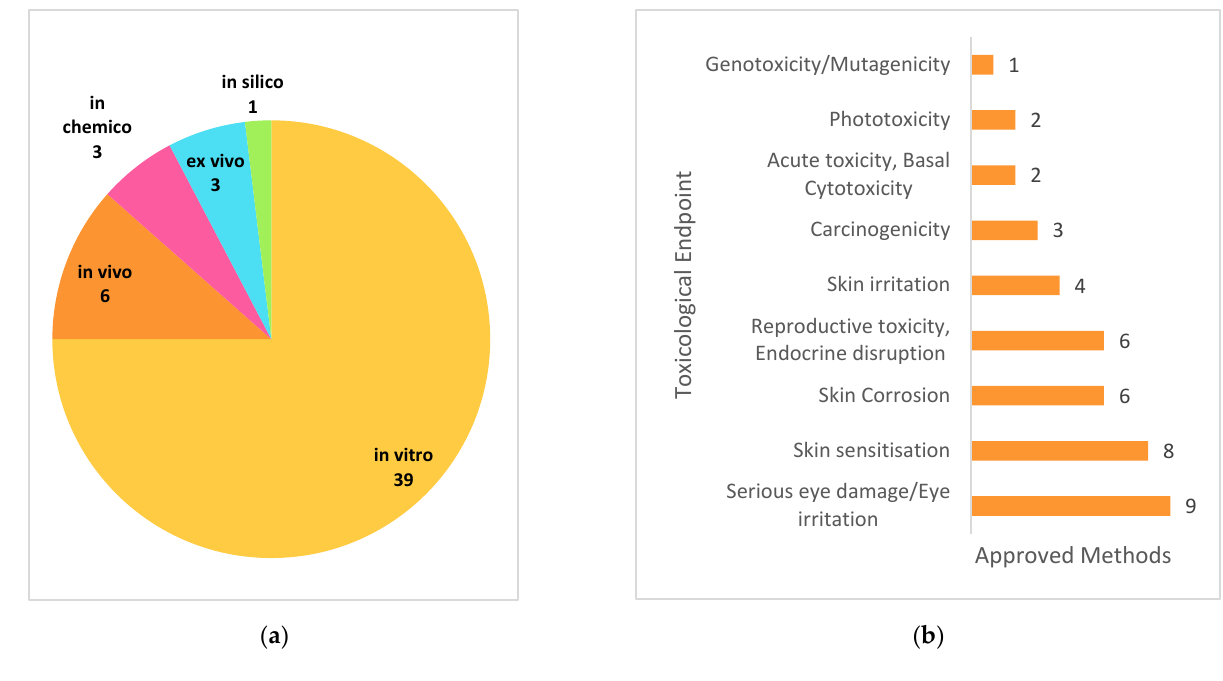
Figure 2. ( a ) Adopted alternative testing methods, based on TSAR data [37]; ( b ) Toxicological endpoints of adopted NAMs related to human safety of cosmetics, based on TSAR data [37]. Table 3. Adopted NAMs relating to toxicological endpoints relevant to human hazard assessment in cosmetics, based on TSAR (modified from